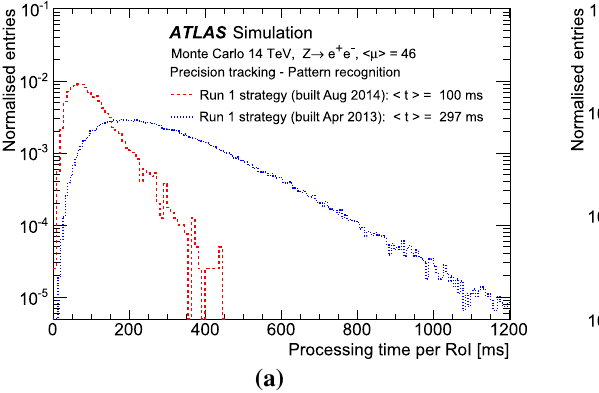
ing time is shown before and after the improvements to the algorithms implemented during the 2013–2015 long shutdown